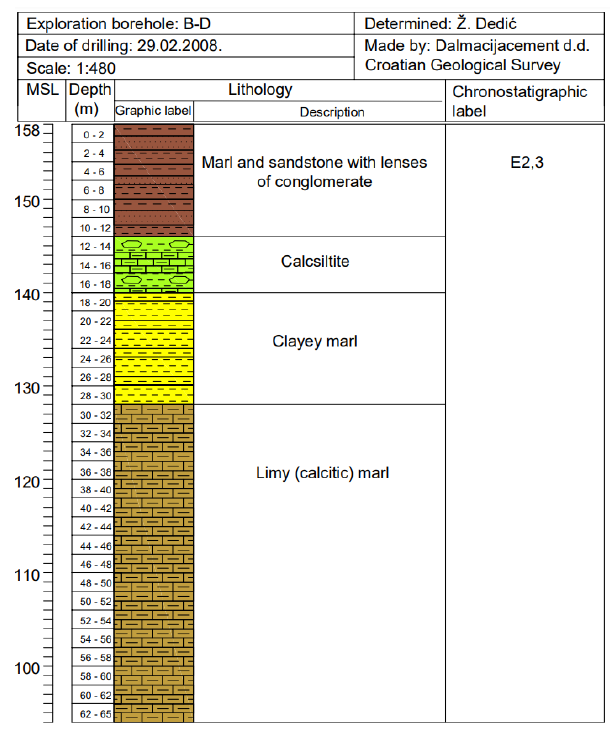
Figure 2. Exploration borehole B–D (according to [23]).